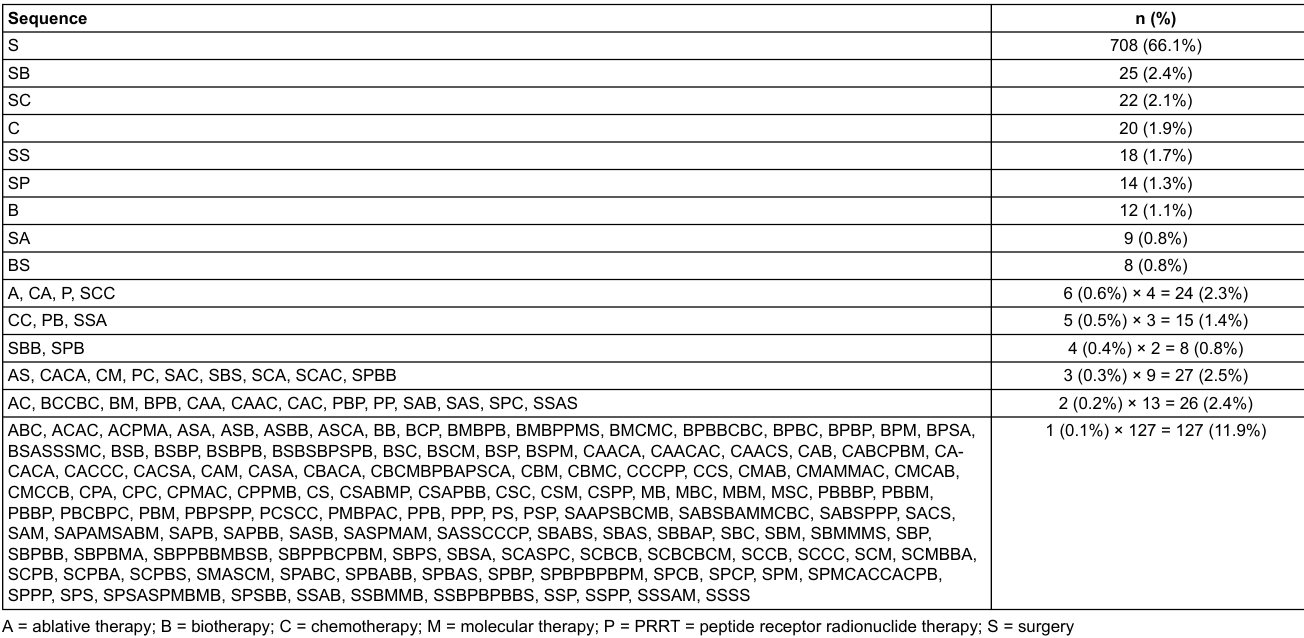
table 5. Seventy-five patients (30%) with a pancreatic NET were treated with either PRRT or systemic therapy or both.